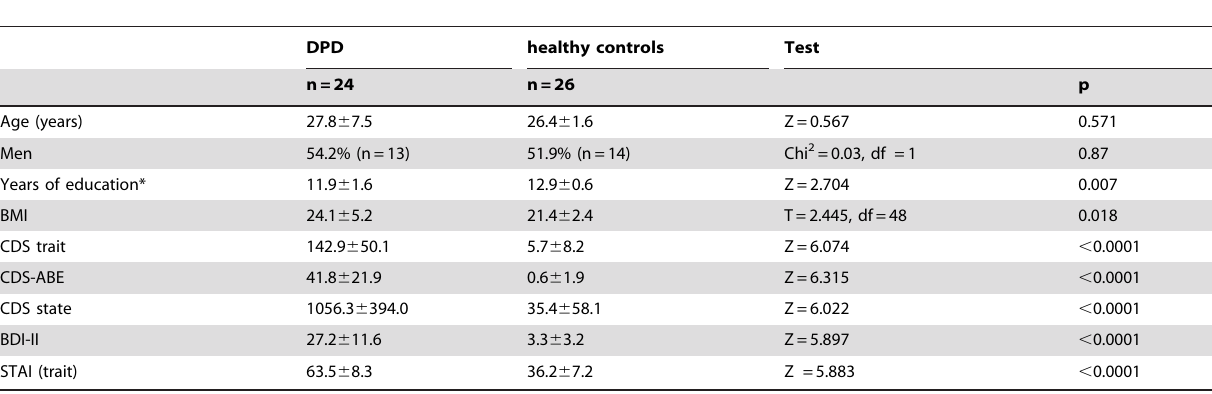
Table 2. Characteristics of the